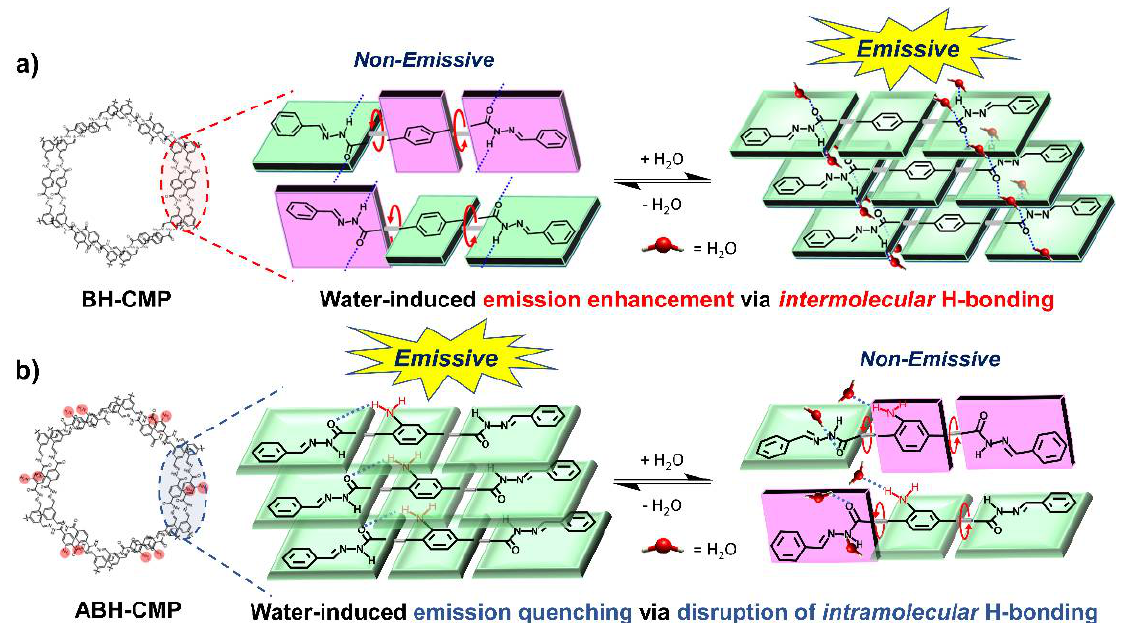
Figure 2. Schematic representation of the proposed mechanism for water-induced fluorescence regulation. ( a ) Emission enhancement in BH-CMP via intermolecular hydrogen bonding with water molecules. ( b ) Emission quenching in ABH-CMP via disruption of intramolecular hydrogen bonding by water molecules.